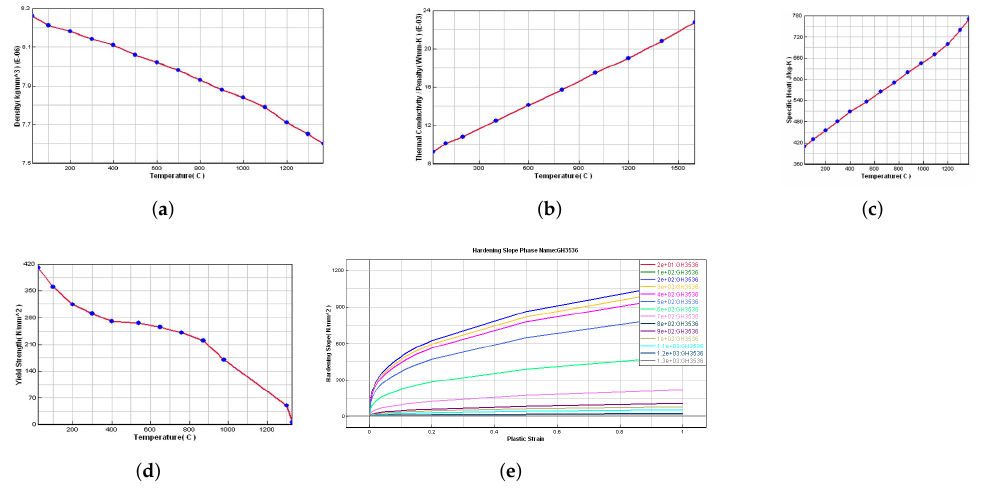
Figure 2. Diagram of material database for GH3536: ( a ) density, ( b ) thermal conductivity, ( c ) specific heat, ( d ) yield strength, and ( e ) stress–strain